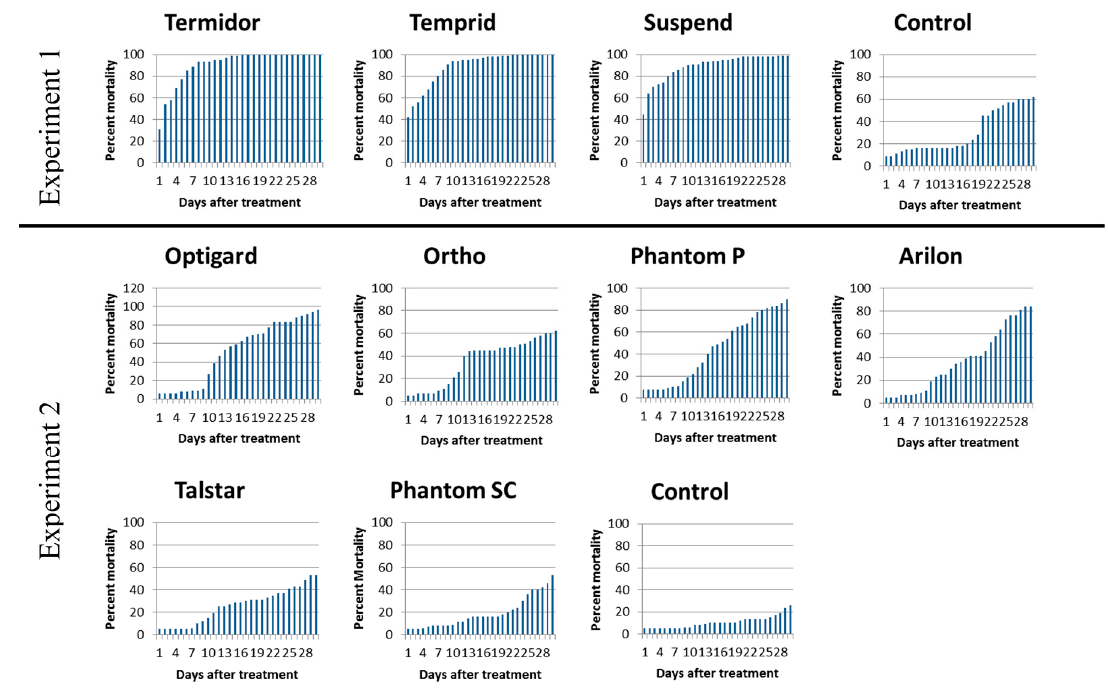
Figure 5. Daily percent mortality of Nylanderia fulva workers over 30 days in a bioassay requiring ants to cross a painted wood panel treated with insecticide or water (control) (n = 5 replicates).